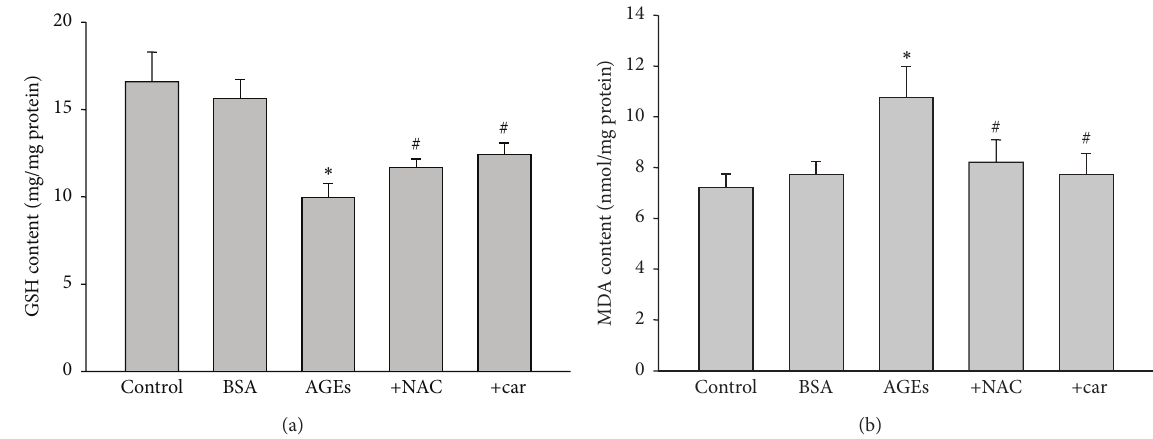
Figure 5: Cariporide recues AGEs-induced oxidative stress in kidney of rats. The rats received a tail vein injection of AGEs (100mg/kg) followed by treatment with or without N-acetylcysteine (200 mg/kg/day) or cariporide (1mg/kg/day) for 12 weeks. At the end of experiments, rats were sacrificed under anesthesia. (a) GSH content and (b) MAD level were determined. All data were expressed as mean ± SD. 𝑁 is 10–15 in each group. ∗ 𝑃 < 0.05 versus BSA. # 𝑃 < 0.05 versus AGEs